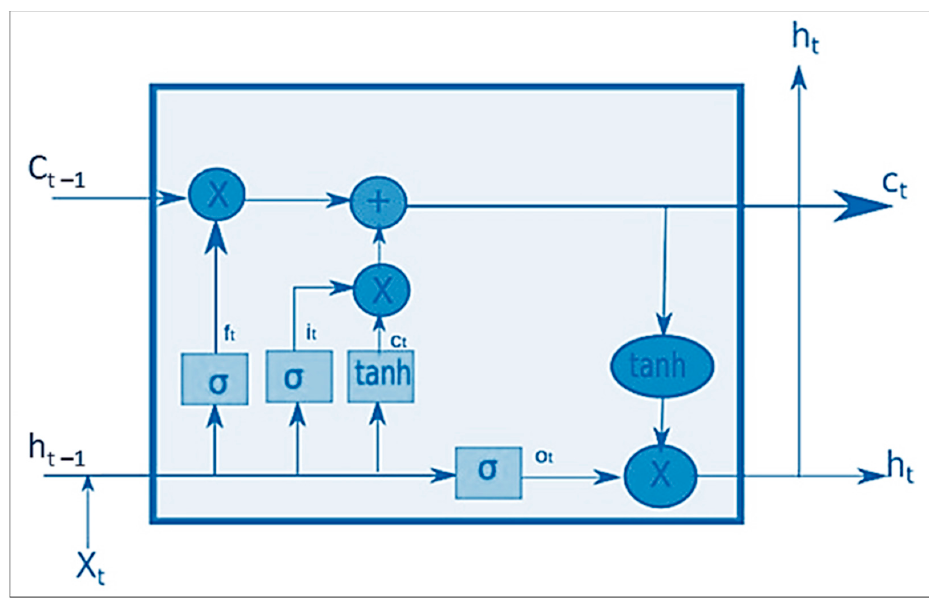
Figure 5. The internal structure of one LSTM cell.